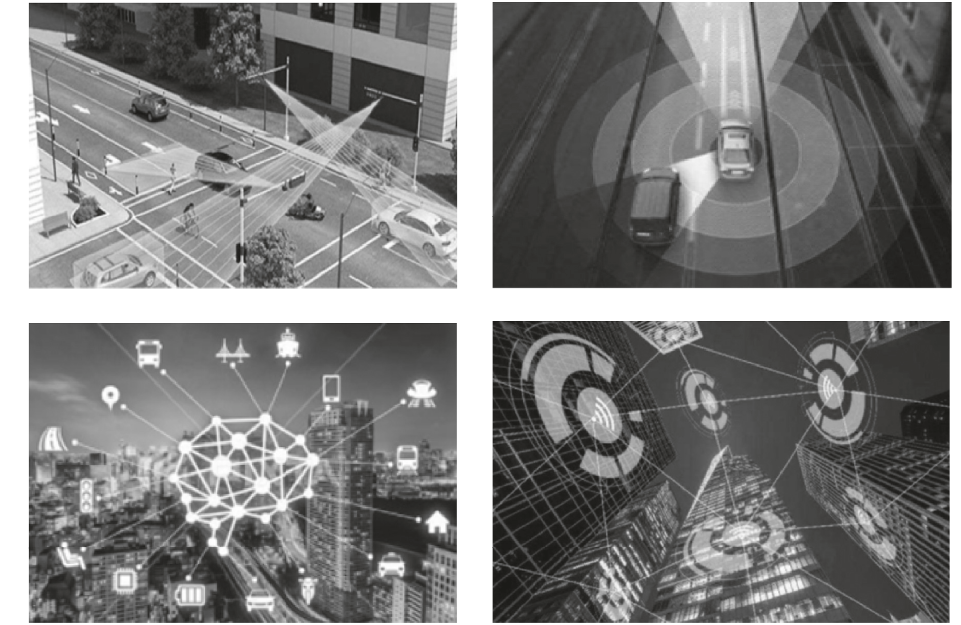
Figure 1: Applications of intelligent transportation.